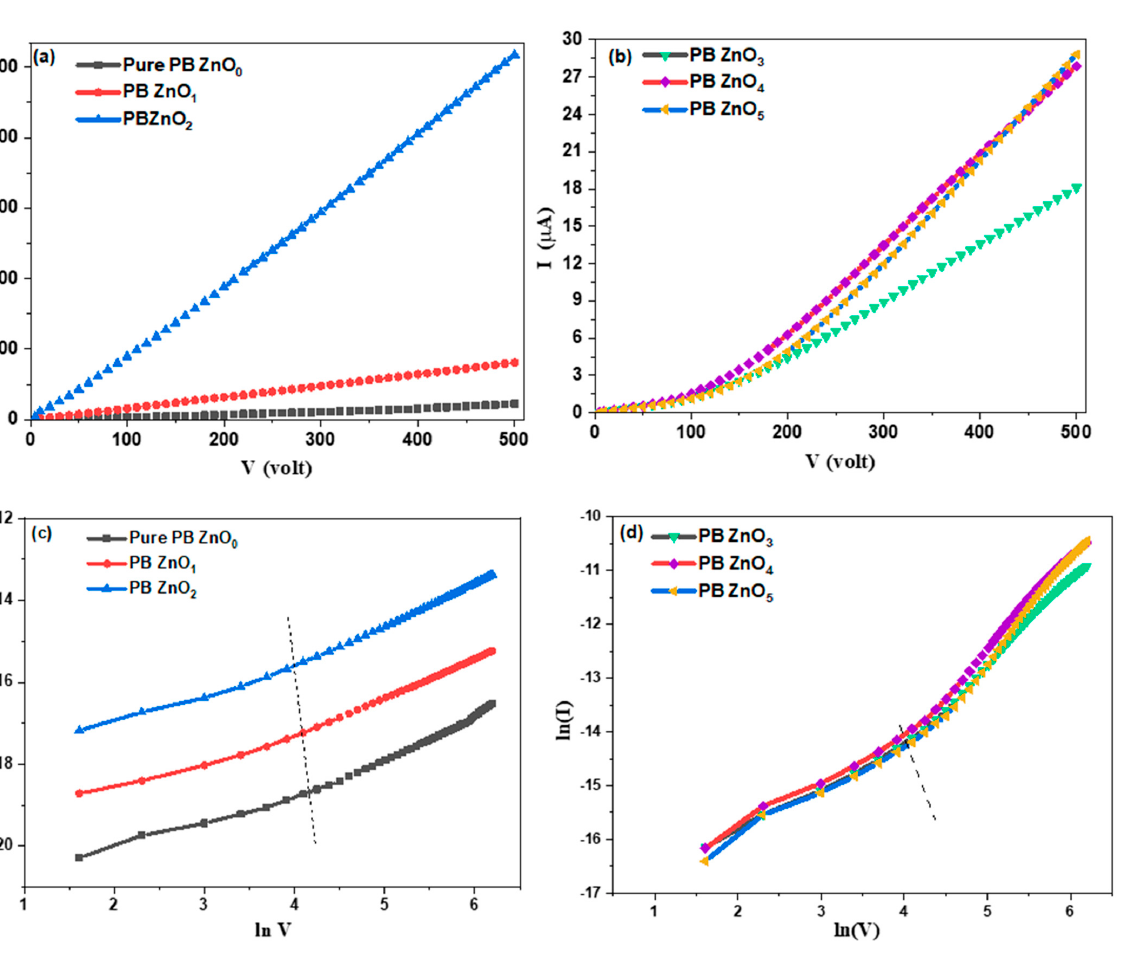
Figure 13. ( a – d ): Variation of current ( I )-voltage ( V ) plots and the corresponding ln( I )-ln( V ) plots of ZnO/(PVA-PVP) polymeric composite